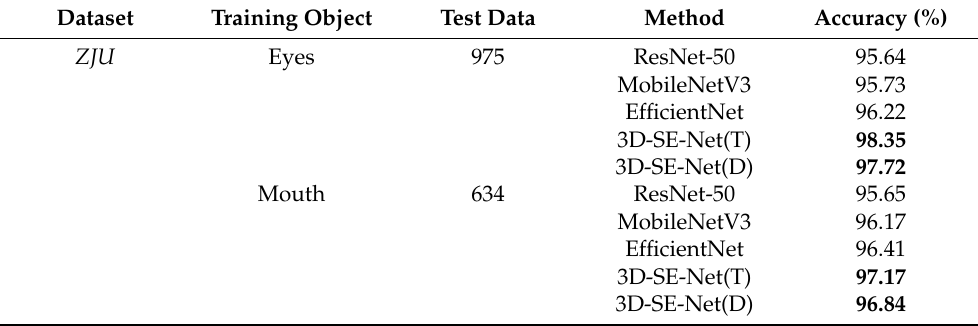
Table 1. Classification accuracy of the proposed method and different classical CNN structures on four datasets (where T stands for Three-branch 3D-SE-Net and D stands for Double-branch